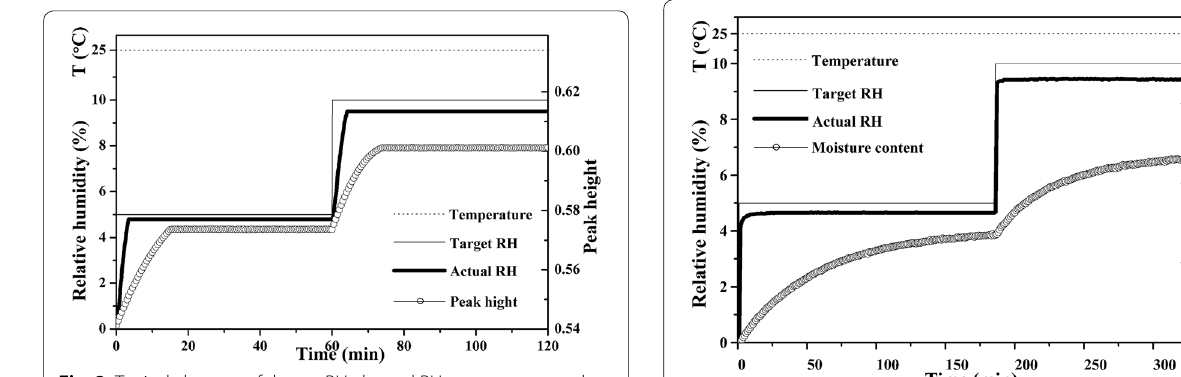
Fig. 2 Typical changes of the set RH, the real RH, temperature and peak height of real-time spectrum with time Fig. 3 Typical changes of MC and RH vs.